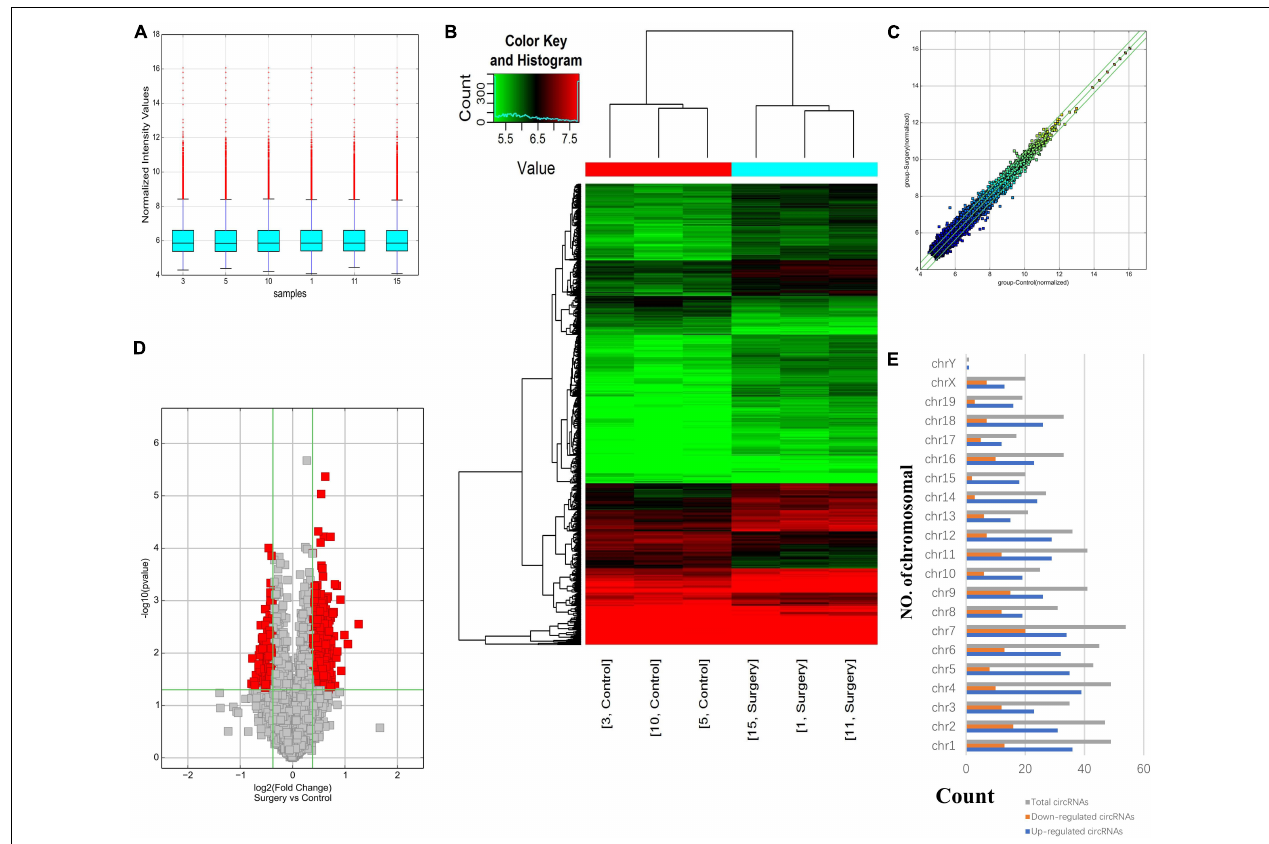
FIGURE 2 | Differentially expressed profile of circRNAs and characterization between the two groups. (A) Box plots showing the distribution of circRNAs between the hippocampus samples, abscissa reports sample name and ordinate reports the normalized intensity values, the upper and lower sides of the rectangular box mean minimum and maximum values, the upper and lower lines of the error bars mean interquartile range, the line inside the rectangular box means median value. (B) Hierarchical clustering plot showing the differentially expressed circRNA profiles in the six samples. “Red” represents the higher expression, while “green” represents the lower expression level. (C) The difference expression of circRNA is shown by a scatter plot between the two groups. (D) Volcano plots visualizing the distinguishable circRNA expression, the abscissa represents significance, the ordinate represents multiple of expression difference. (E) Chromosomal distributions